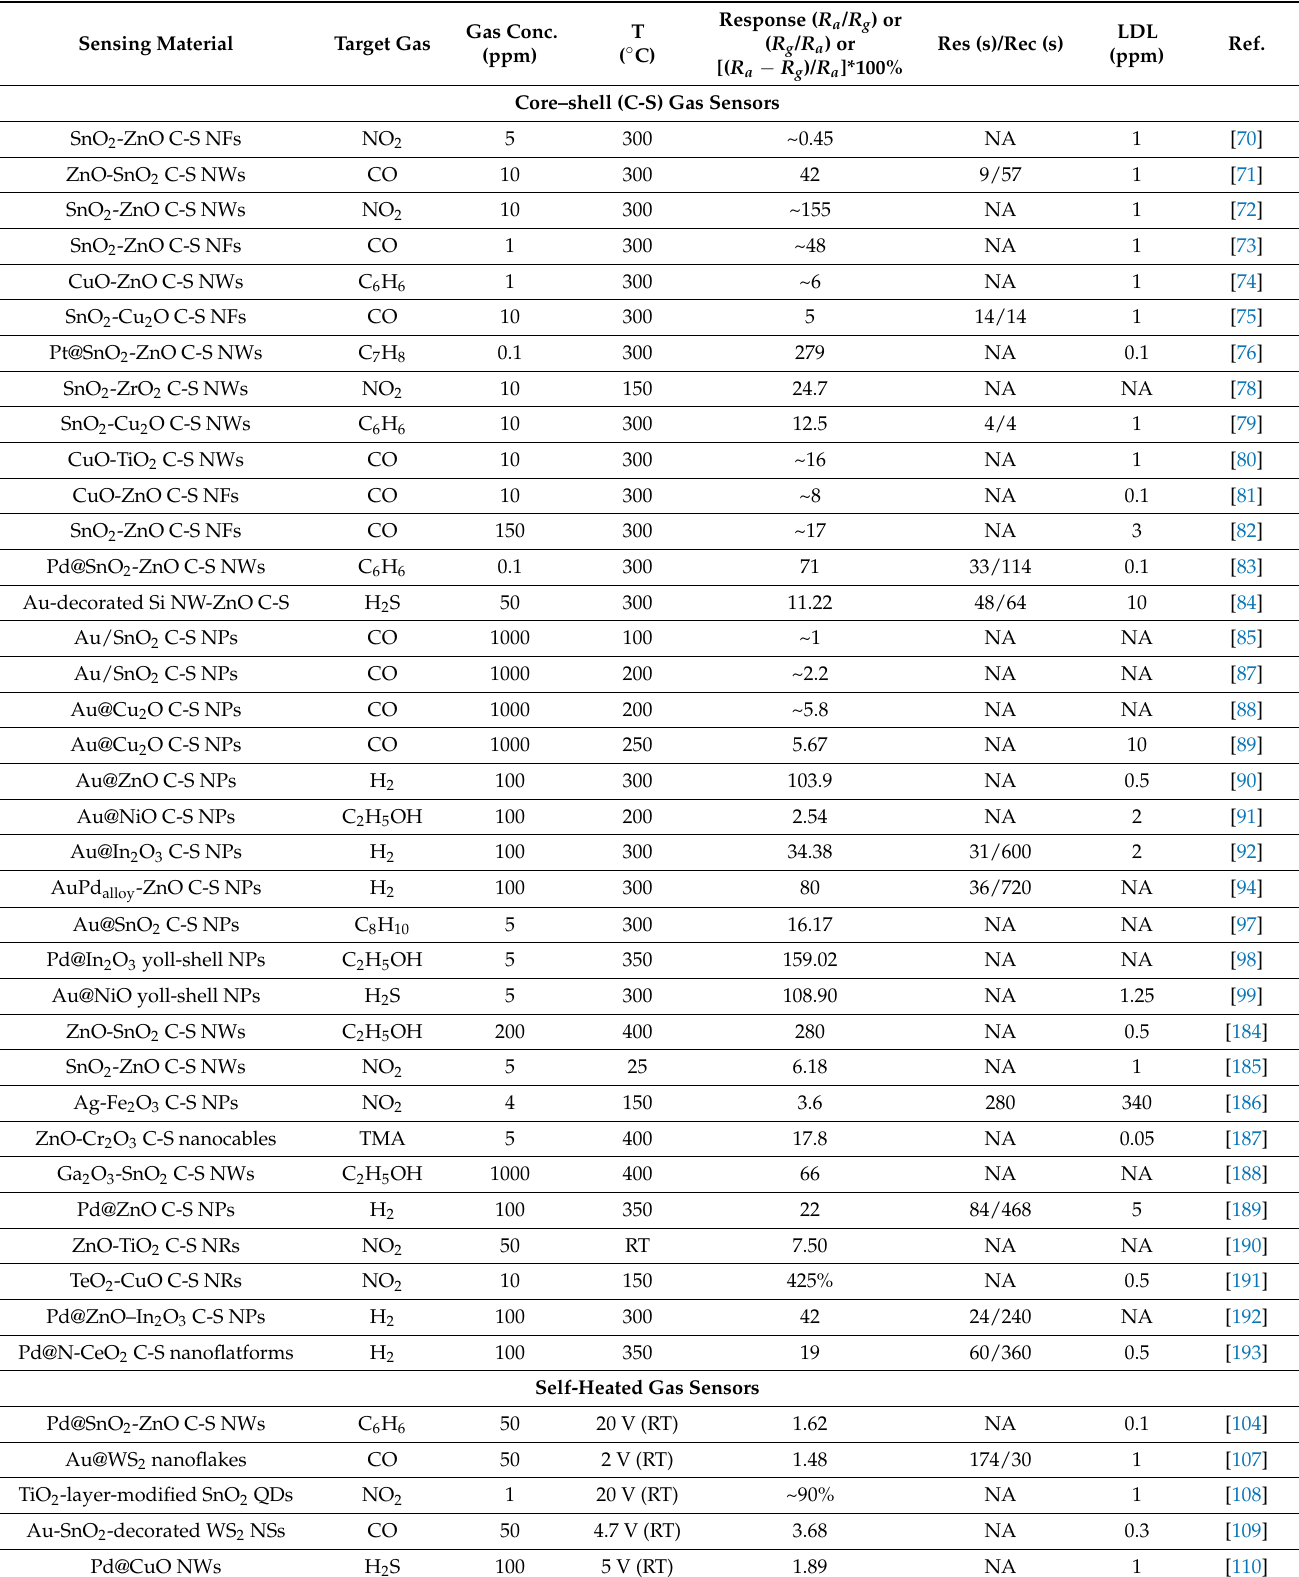
Table 3. Comparison of gas detection performances of different types of gas sensors reported by different research groups in